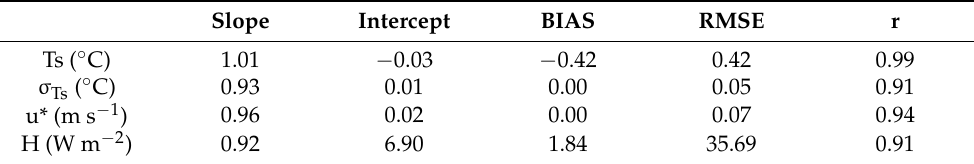
Figure 8. Comparison between 3-D sonic anemometers for micrometeorological tower 1 (black curves) and 2 (gray curves). Averaging time was 1.0 min with a sampling rate of 20 Hz. Table 5. Regression results for the comparison of the turbulent quantities of sonic temperature (Ts), standard deviation of Ts ( σ Ts ), friction velocity (u*), and turbulent heat fluxes (H), plus estimates for bias, comparability (RMSE), and Pierson’s coefficient (r). Slope Intercept BIAS